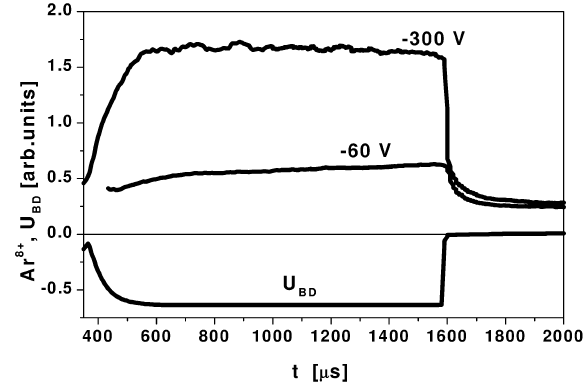
FIG. 4. Time structure of Ar 8 1 ion currents from pure argon plasmas for biased-disk voltages of 2 60 and 2 300 V. The bottom curve represents the shape of the biased-disk voltage pulse U BD . The option with slow rise time and fast fall time (cid:2) 100 m s (cid:1) 10 m s (cid:3) of the pulse generator has been chosen.